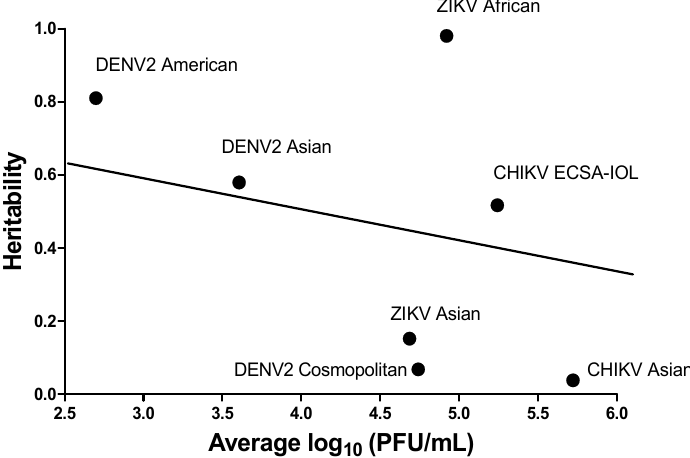
σ 2 s = average variance among offspring of a single sire; h 2 = narrow-sense heritability (h 2 = Va/Vp). * p = 0.03–0.05, ** p = 0.001, *** p < 0.00001.